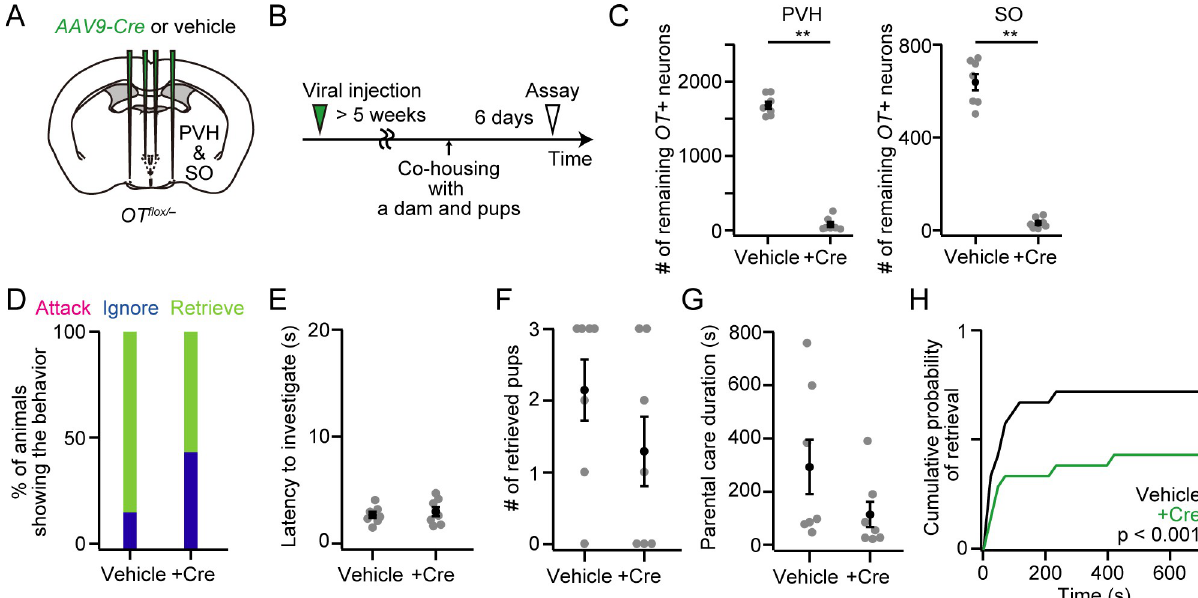
Fig 3. OT cKO in the PVH and SO in virgin females increases the probability to ignore pups. (A) Schematic of the viral injection. AAV-Cre or vehicle was injected into the bilateral PVH and SO. (B) Schematic of the timeline of the experiment. A behavioral assay was performed 6 days after co- habiting with a mother and pups (see Materials and Methods). (C) Number of remaining OT+ neurons ( �� p < 0.01, two-sided Mann–Whitney U- test). n = 7 each. (D) Percentage of females showing attack, ignore or retrieve. +Cre females were more likely to ignore the pups (p < 0.001, two-tailed Fisher’s exact test). (E) Latency to the first investigation of pups was not statistically different (two-sided Mann–Whitney U- test). (F) Number of retrieved pups (p > 0.27, two-sided Mann–Whitney U- test). (G) A decrease in parental care duration was found in +Cre females but did not reach the level of statistical significance (p > 0.15, two-sided Mann–Whitney U- test). (H) Cumulative probability of pup retrieval. The p-value is shown in the panel (Kolmogorov–Smirnov test). Error bars, standard error of the